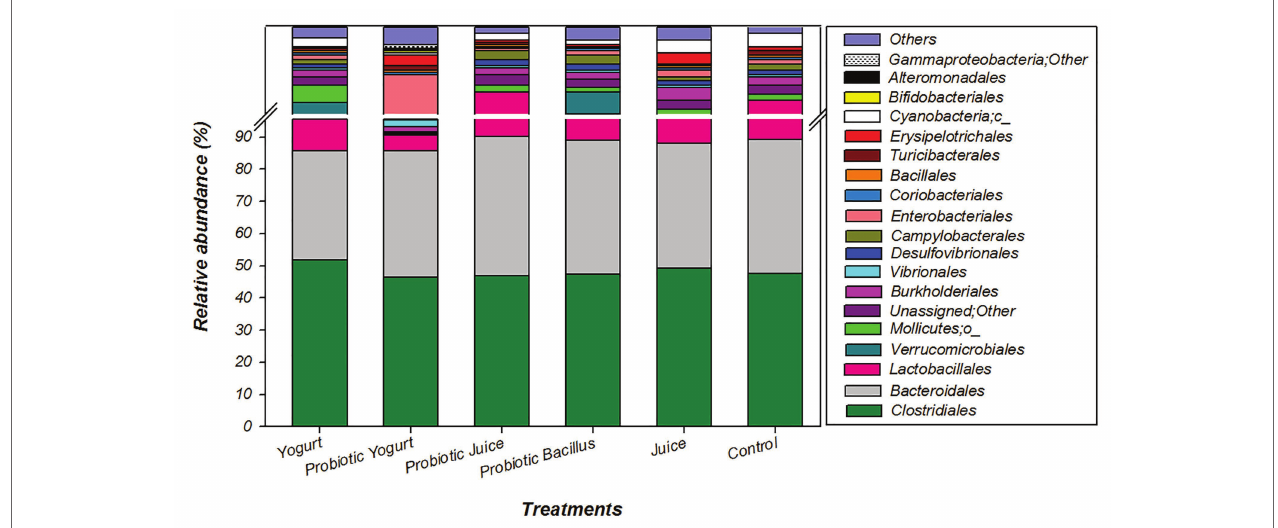
FIGURE 2 | Relative abundance of bacterial groups inferred from 16S rRNA gene amplicon sequencing analysis from samples of each experimental or control group. Groups were as follows: Control: received distilled water; Juice: received orange juice; Yogurt: received yogurt; probiotic Bacillus : received B. coagulans GBI-30 6086 suspended in distilled water; Probiotic Juice: received orange juice with B. coagulans GBI-30 6086; and Probiotic Yogurt: received yogurt with B. coagulans GBI-30 6086.